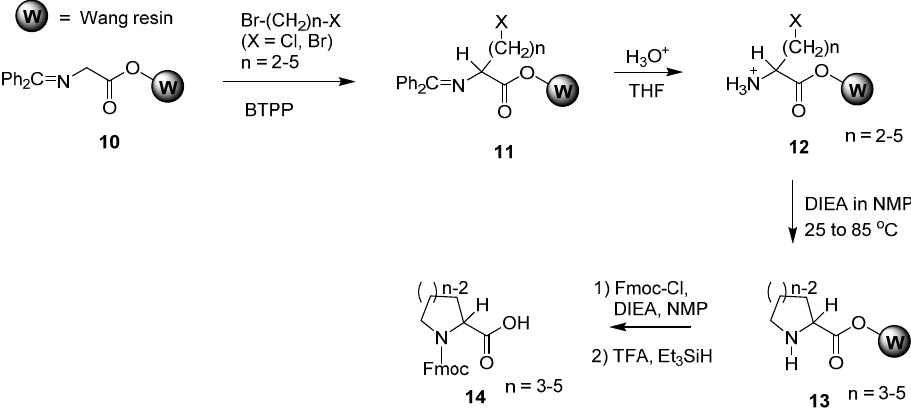
Scheme 1. Solid-phase synthetic routes to compounds 1 and 2 using BAL-based resins.